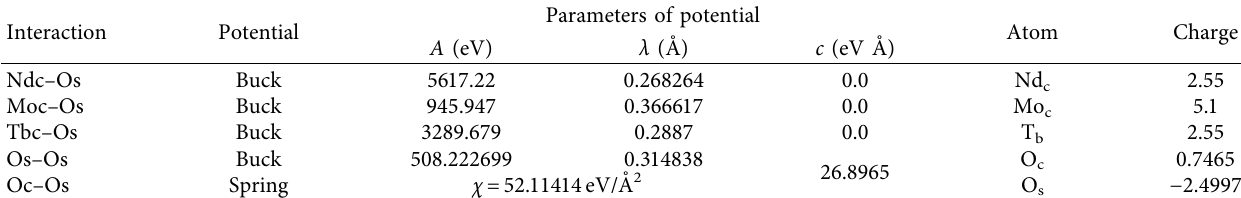
Table 1: Parameters of pair interaction potential and charges of atomic cores (c) and shells